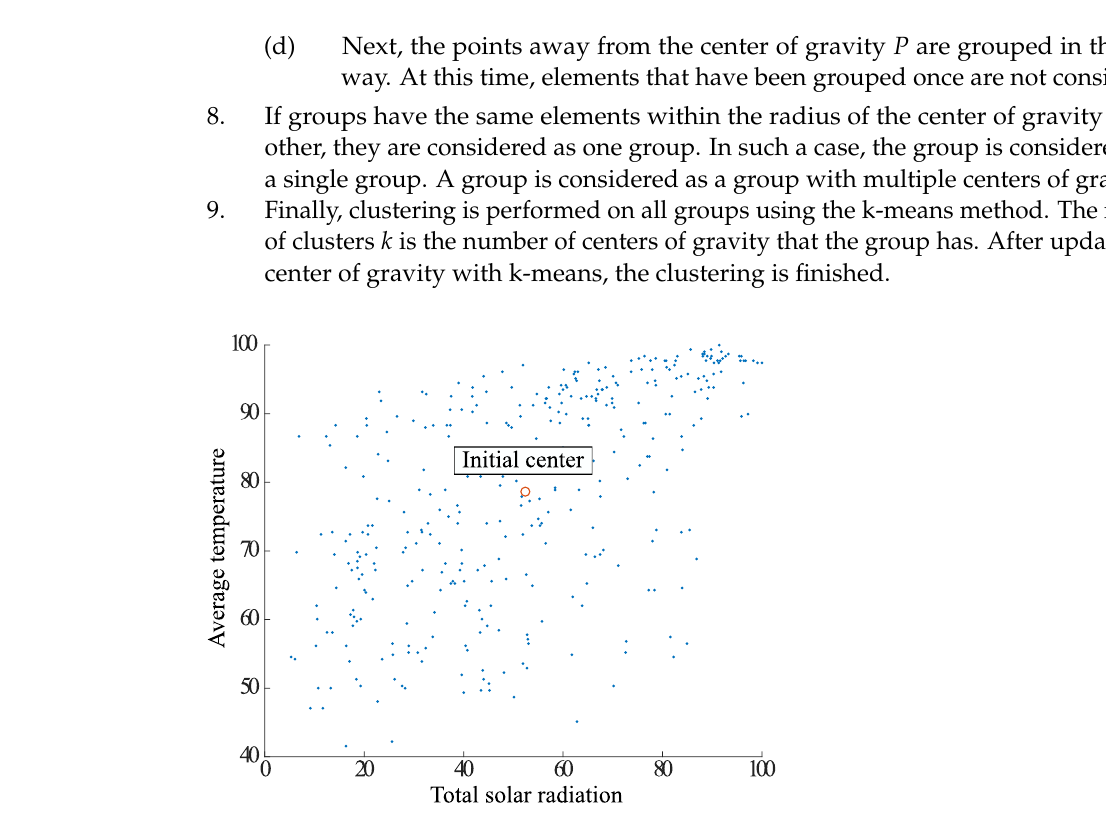
Figure 14. Step 1 result (Initial center:P).